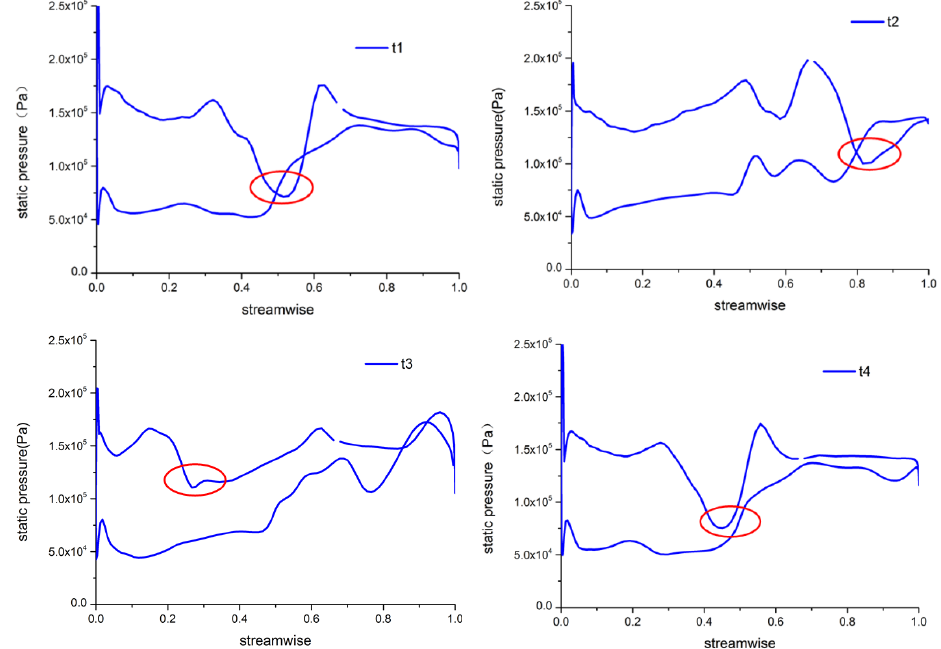
Figure 17. The tip load curves at 99% span in an unsteady period for 20% axial slots.